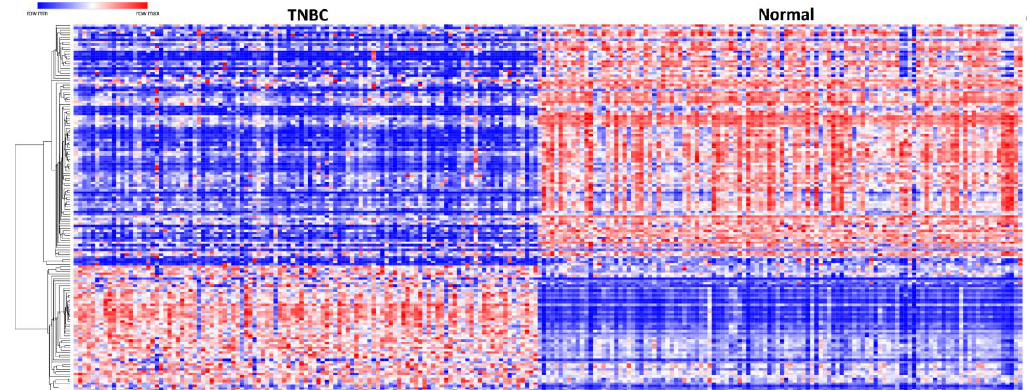
Figure 4. Patterns of gene expression profiles for the 154 gene signatures derived from the 55 genes containing germline mutations only and 99 genes containing somatic mutations only. The red color represents upregulation and blue color represents downregulation.